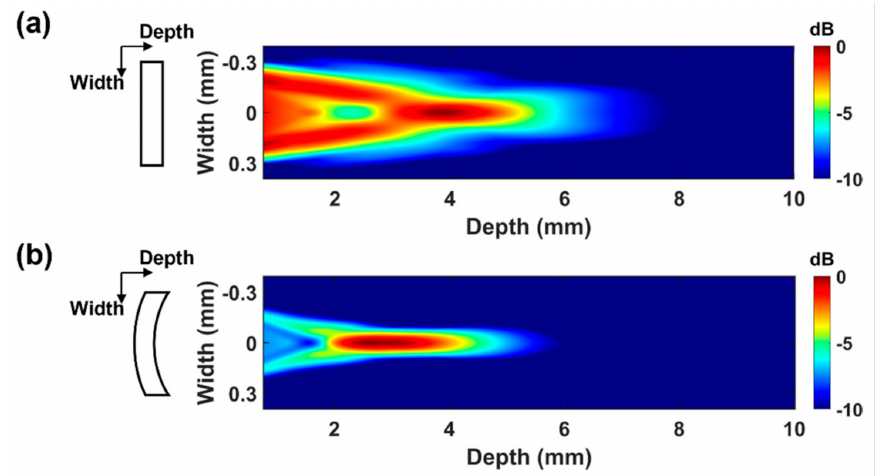
Figure 6. One-way radiation patterns of 80-MHz IVUS transducer with 0.6-mm aperture diameter according to aperture shape. ( a ) IVUS transducer with flat aperture and its one-way radiation pattern, and ( b ) IVUS transducer with spherically press-focused aperture and its one-way radiation